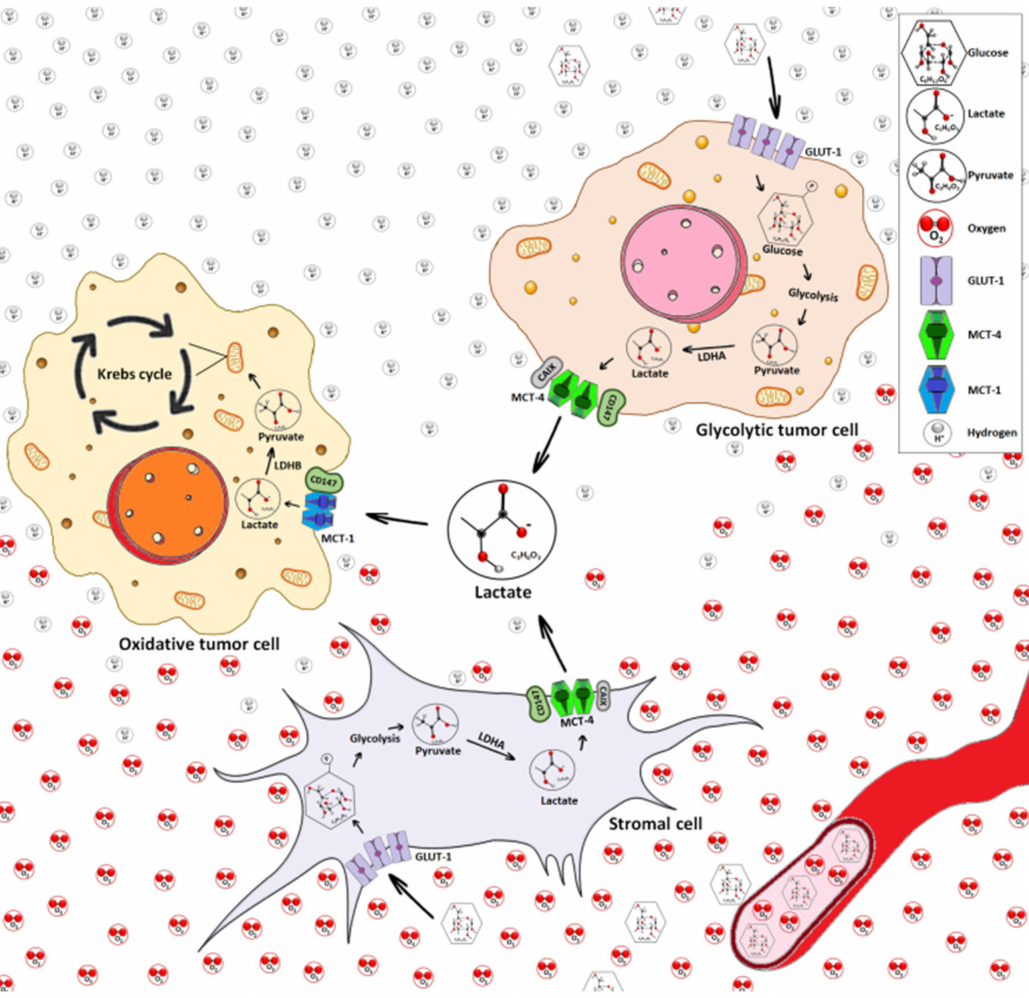
Figure 2. Intercellular lactate exchange in the tumor microenvironment (TME). The TME is a complex ultrastructure containing di ff erent cell types, including tumor cells, stromal cells, immune cells, blood vessels and cellular metabolites such as lactate. Oxidative tumor cells (orange nuclei) and stromal cells (gray cytoplasm) are supported by a favorable location with high nutritional and O 2 availability. Oxidative tumor cells (orange nuclei) express MCT1 transporter which preferentially promotes lactate import. The glycolytic tumor cells (pink nuclei) produce lactate by the glycolytic pathway that culminates in the final reaction mediated by lactate dehydrogenase LDHA, and exhibit high expression of MCT4 favoring lactate export. Lactate can be used as an energetic source through its conversion to pyruvate via LDHB and then go to into the Krebs cycle for energy generation. Thus, the glycolytic tumor cell (pink nuclei), and stromal cell (gray) interchange of lactate with oxidative tumor cells (orange nuclei) increases tumor cell survival and proliferation. CD147: chaperone. CAIX: carbonic anhydrase IX. Made from the original idea